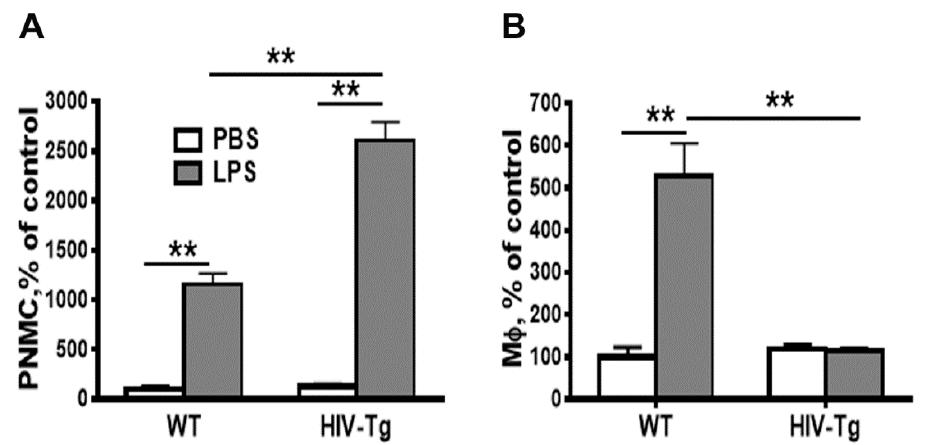
Figure A2. Infiltration of lung neutrophil is increased and lung macrophage is decreased in HIV-Tg mice at 24 hrs after LPS injection. ( A , B ) Quantification of lung neutrophils (A, PNMC) and lung macrophages (B, M ϕ ) infiltration. Results are shown as percent of WT-PBS level. Mean and standard error are shown. Asterisks indicate: ** p < 0.01.